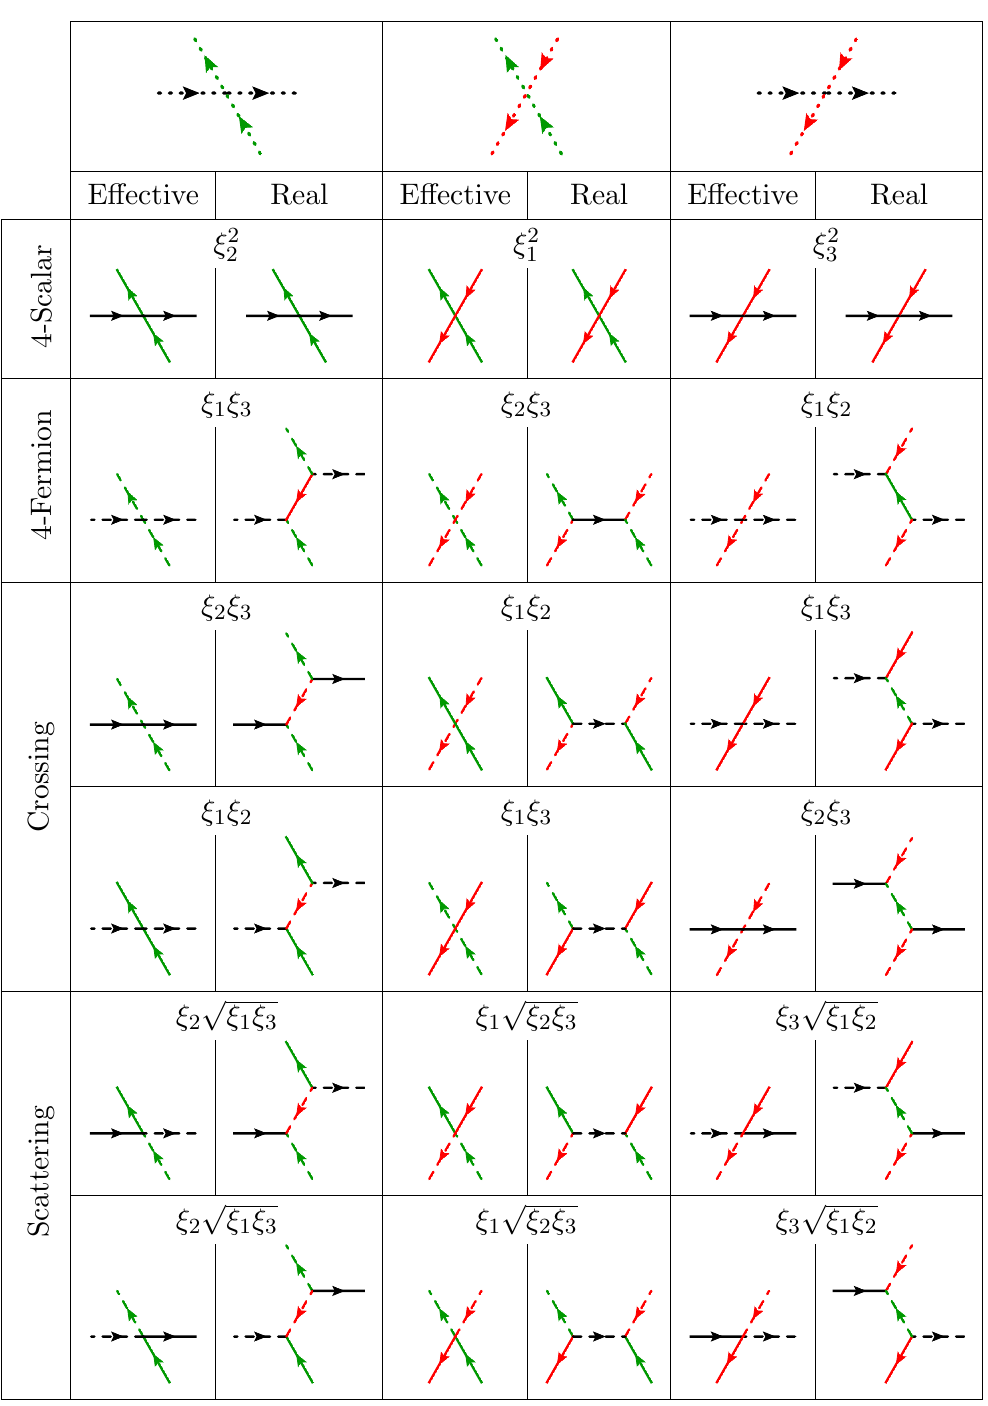
Table 1 . Substitution rules for the e(cid:11)ective vertices appearing in the (cid:12)shnet bulk structure of (cid:12)gure 2 in terms of the Feynman rules of (cid:12)gure 1. Any e(cid:11)ective vertices is associated with a combination of the coupling constants (cid:24) i with i = 1 ; 2 ; 3 of order (cid:24) 2 .